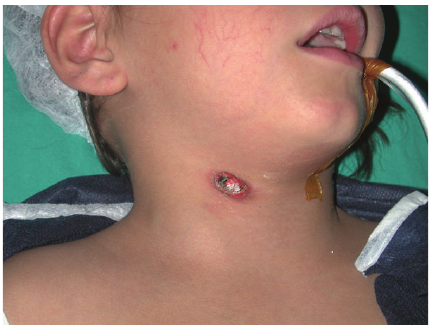
Figure 2: Foreign body in the right side of the neck before removal.